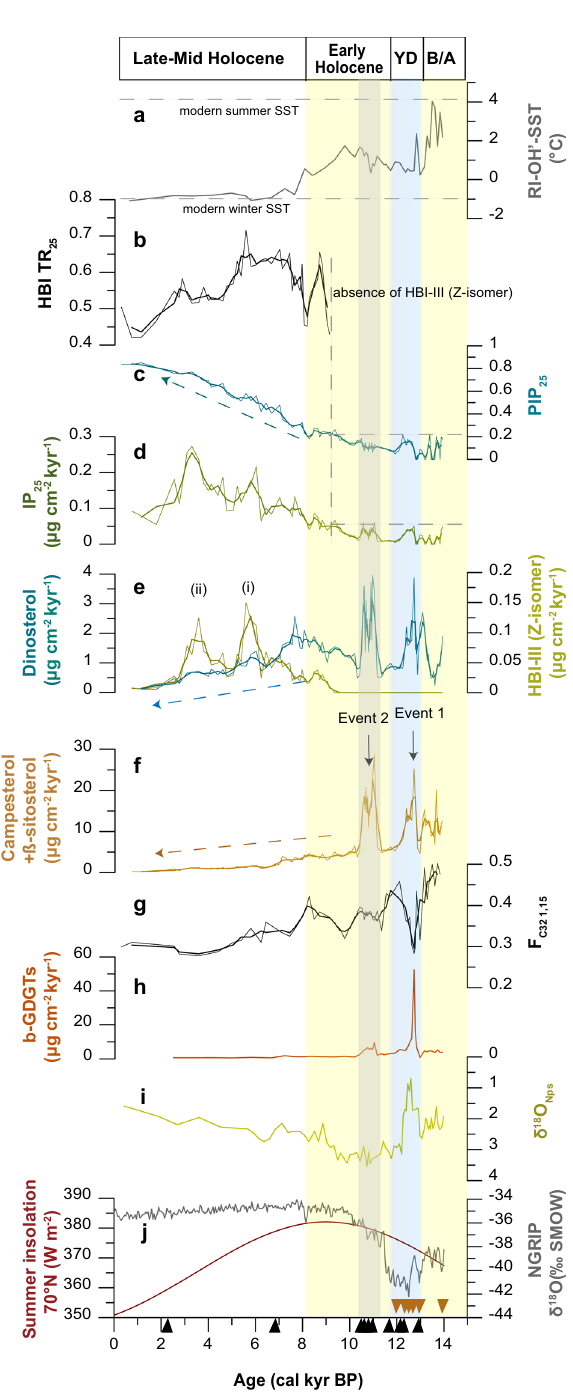
Fig. 7 Proxy records for surface water characteristics. Compilation of proxies from Core ARA04C/37 ( a – h ) and Core JPC15 ( i ). a Sea surface temperature proxy RI-OH ′ -SST; b spring phytoplankton bloom proxy HBI TR 25 ; c sea-ice proxy PIP 25 based on dinosterol; d IP 25 ; e dinosterol (blue) and HBI-III (yellow); f terrigenous biomarkers; g F C32 1,15 , fractional abundance of C 32 1,15-diol; h b-GDGTs; d – f are biomarker accumul- ation rates. i δ 18 O values of Neogloboquadrina pachyderma in Core JPC15 19 . j Summer insolation (gray) 47 and δ 18 O values from NGRIP ice core (red) 57 . Triangles refer to AMS 14 C dates used in the age – depth model (see Fig.